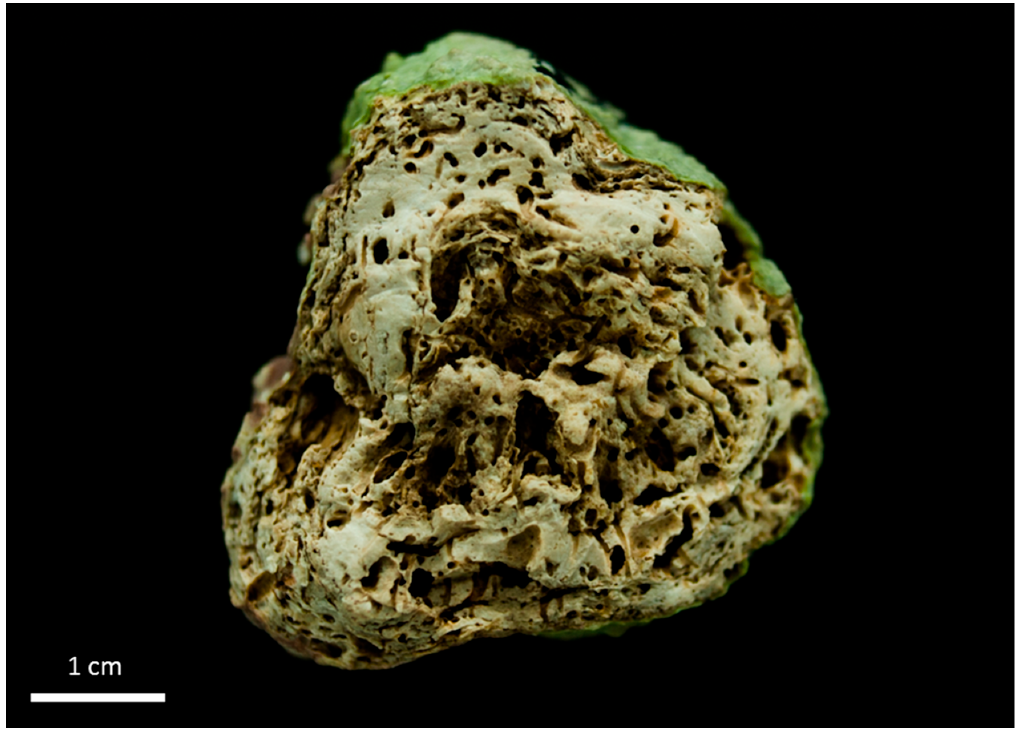
Figure 5. Cross-section of a rhodolith displaying the “boxwork” structure.